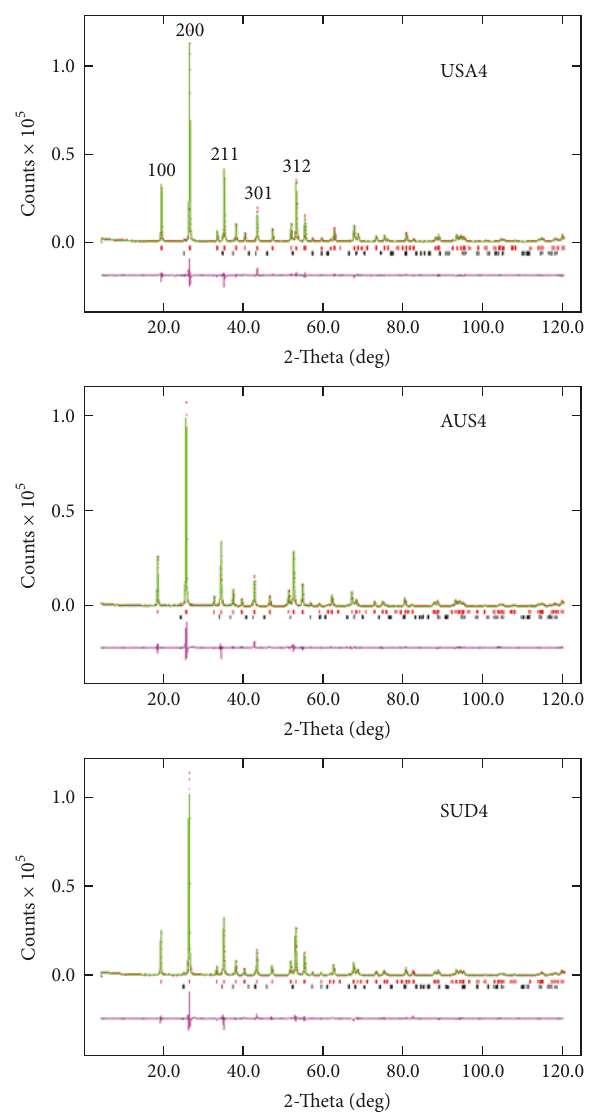
Figure 1: Rietveld refinements results for micronized zircon sands. Points are the experimental data while full line is the results from the fits. Column bars below represent peak position for zircon and corundum phases. The full line below represents the difference from data to